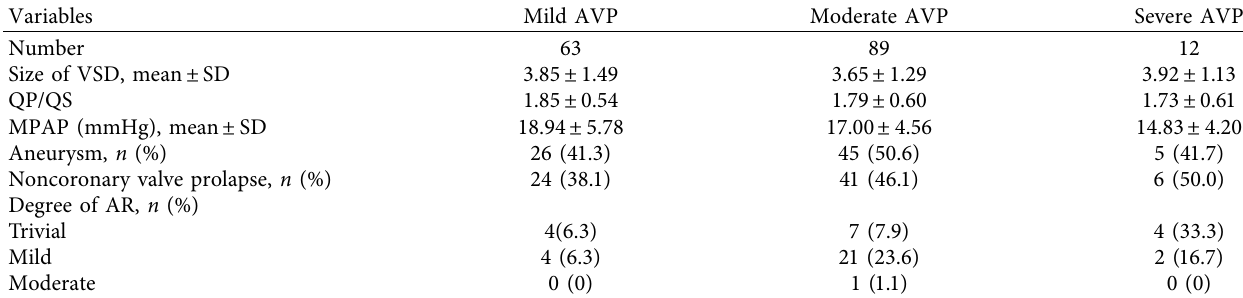
Table 2: Radiographic data for different degrees of aortic valve prolapse.